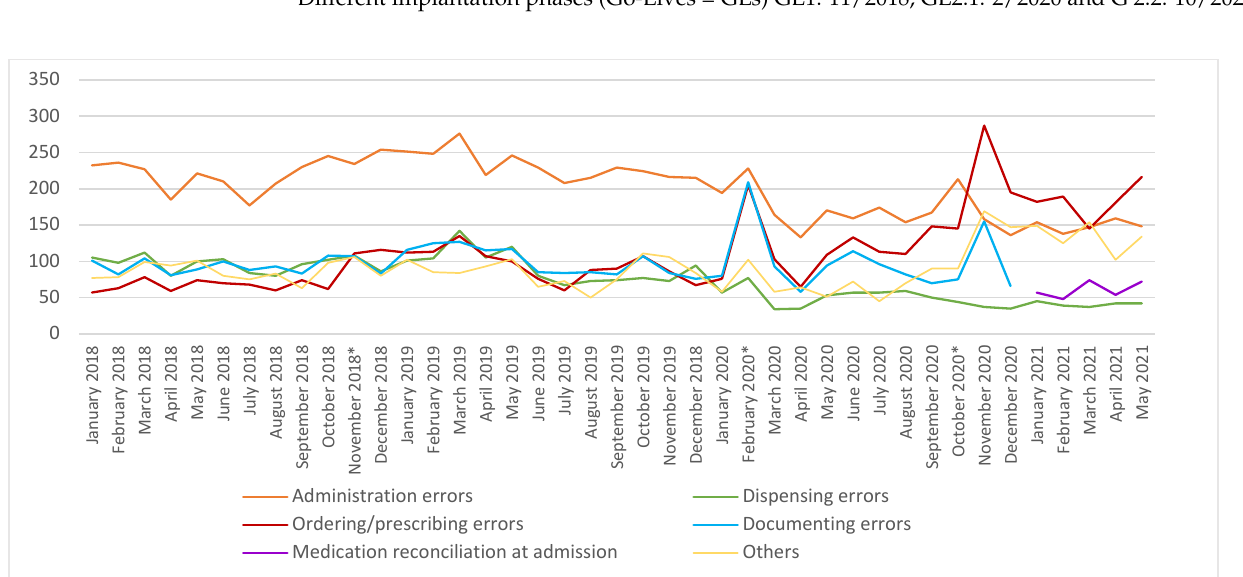
Figure 2. Trends in the medication error subtypes during 1/2018 – 5/2021. * Different implantation phases (Go-lives = GLs) GL1: 11/2018, GL2.1: 2/2020 and GL2.2. 10/2020. Others: Preparing and compounding, ordering drugs from the pharmacy, delivering drugs from the pharmacy, storage errors, unexpected reactions in a patient, not known, and monitoring errors (new type added in 2021). The medication reconciliation at admission error subtype was added, and documenting of the error subtype was removed from the HaiPro system at the beginning of 2021.